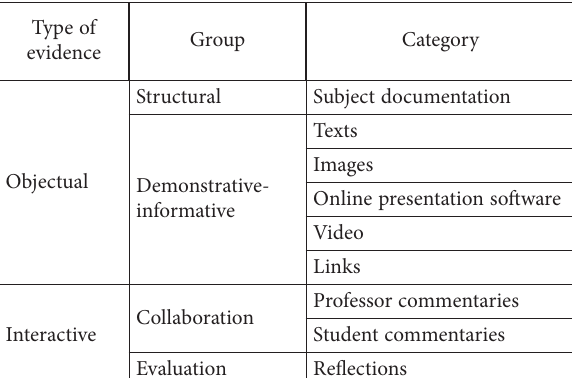
Table 2. Structure for the evidence organization (source: Authors,